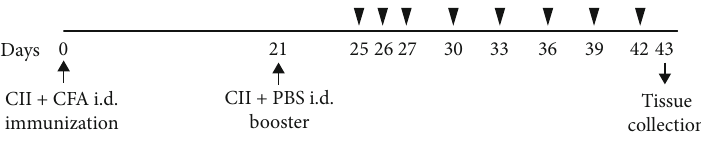
Figure 1: Induction of experimental arthritis and anti-IL-33 treatment. DBA/1 mice were immunized by an intradermal (i.d.) injection of bovine type II collagen (CII) emulsi fi ed in complete Freund ’ s adjuvant (CFA) on day 0 and an intraperitoneal (i.p.) booster injection of CII dissolved in phosphate-bu ff ered saline (PBS) on day 21. To evaluate the e ff ect of anti-IL-33 on experimental arthritis, mice ( n = 10 ) were injected i.p. with anti-mouse IL-33 (150 μ g/mouse) on days 25, 26, 27, 30, 33, 36, 39, and 42. The control group was injected with the same dose of control IgG ( n = 10 ). On day 43, mice were killed, blood was collected, and joints were used for histological analysis.